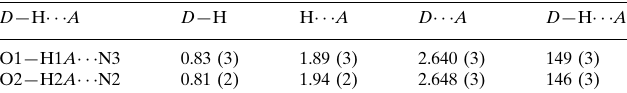
Rigaku SCXmini diffractometer Absorption correction: multi-scan ( CrystalClear ; Rigaku, 2005) T min = 0.907, T max = 0.915